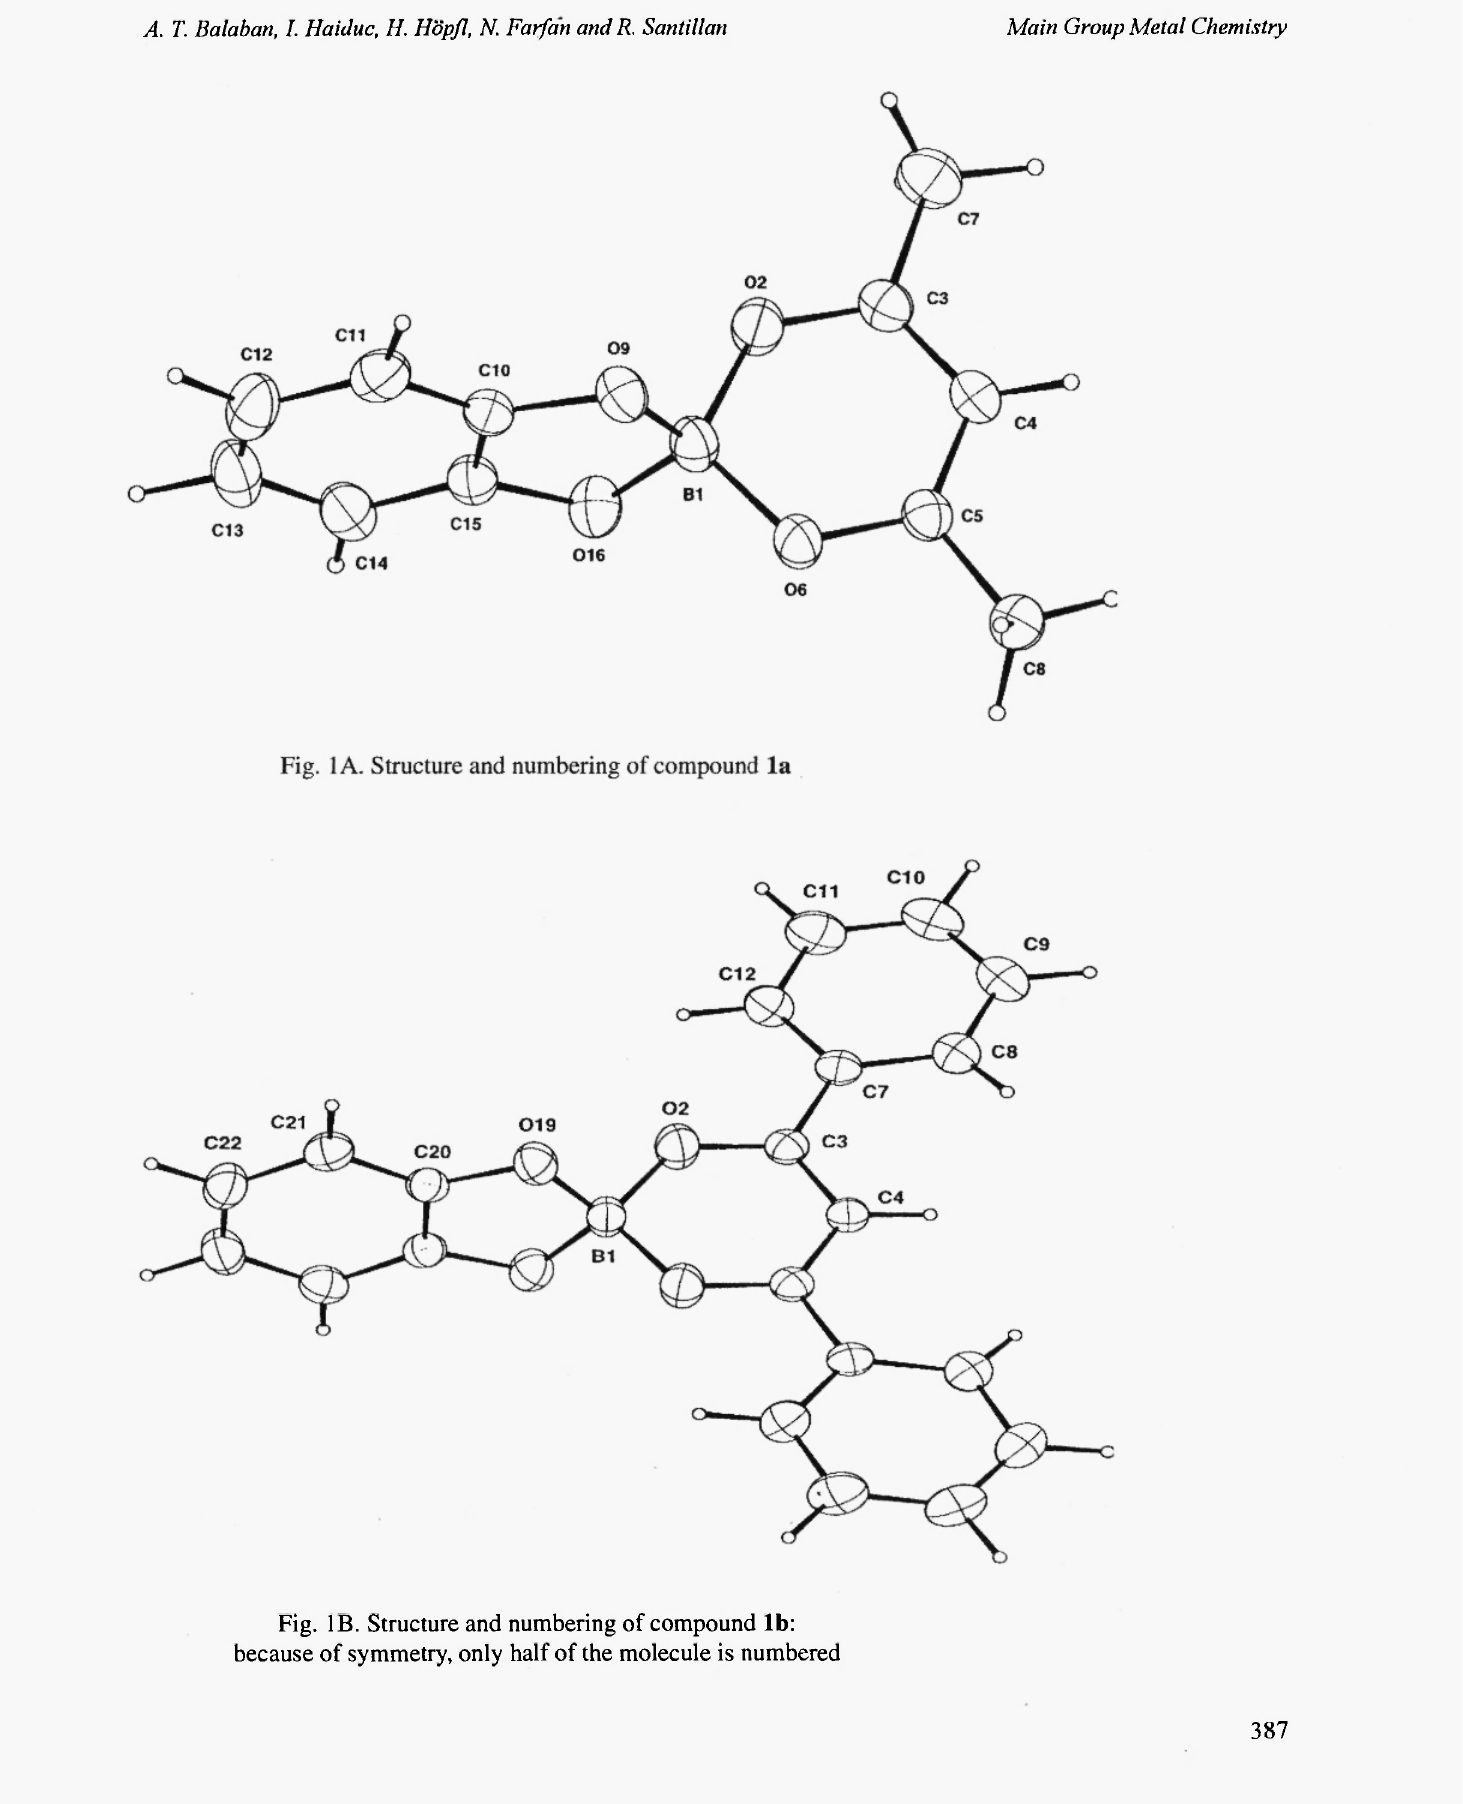
Fig. IB. Structure and numbering of compound lb: because of symmetry, only half of the molecule is